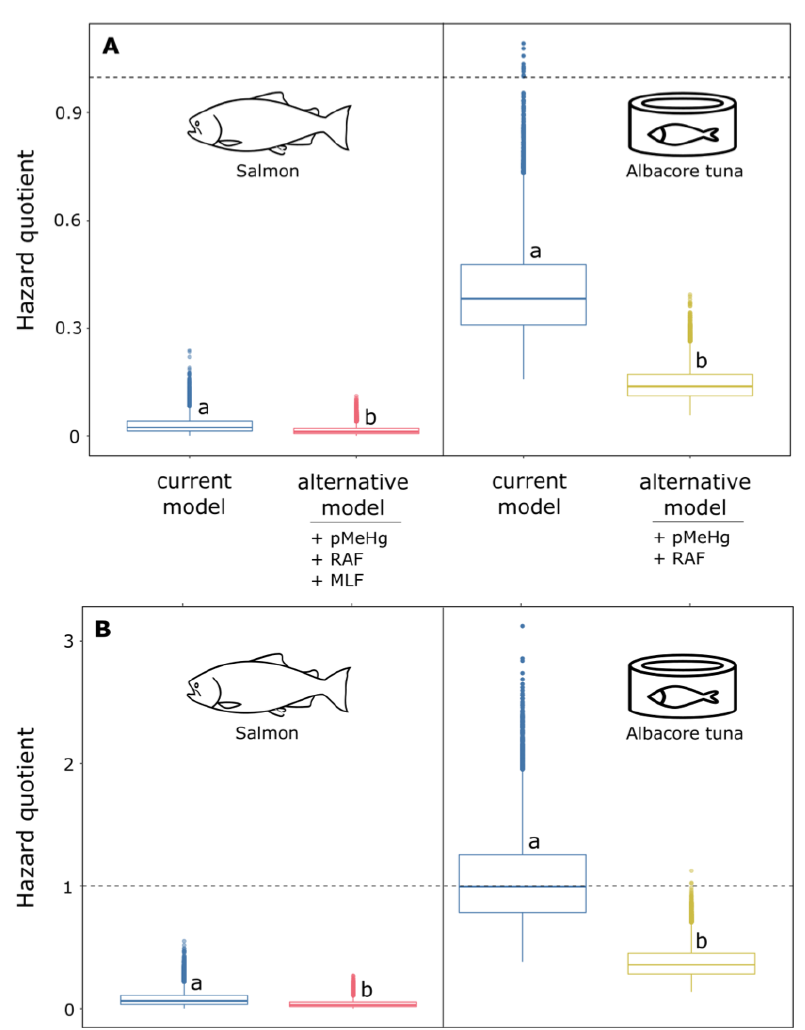
Figure 1. Hazard quotient as function of the fish species consumed and as function of the variables used in the assessment of MeHg exposure. High consumption rate scenario was used. ( A ) Canadian general population and ( B ) sensitive Canadian general population. Letters are used to indicate a significative difference ( p < 0.05) between HQ distribution of a given fish species. See Table S1 for the details of variables used for each scenario. pMeHg: proportion of THg that is methylated; RAF: relative absorption factor; MLF: mass loss factor.